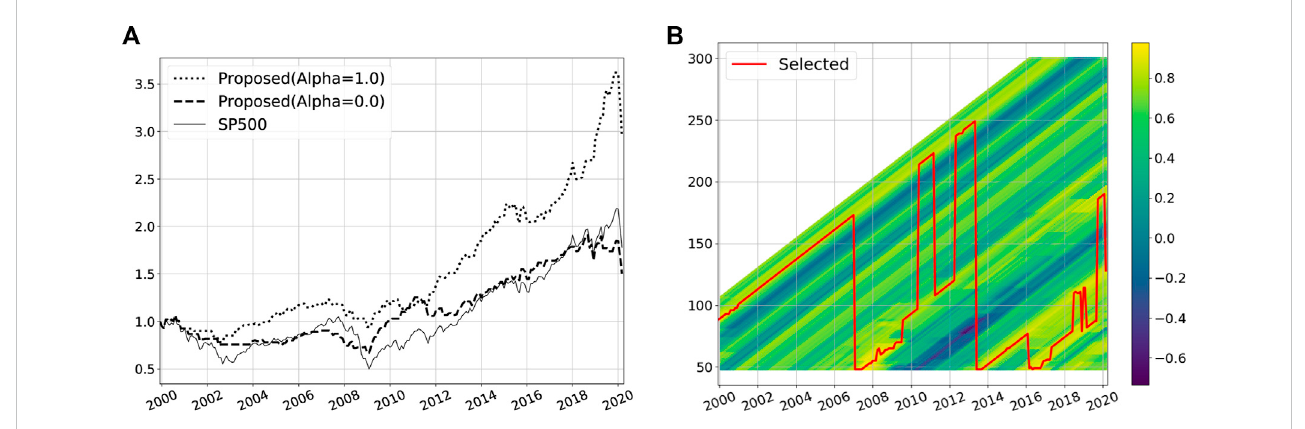
FIGURE 2 Investment Results (A) and Attention (B) of